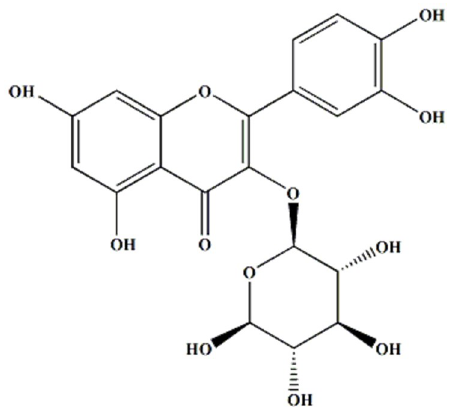
Figure 1. Chemical structure of isoquercitrin.